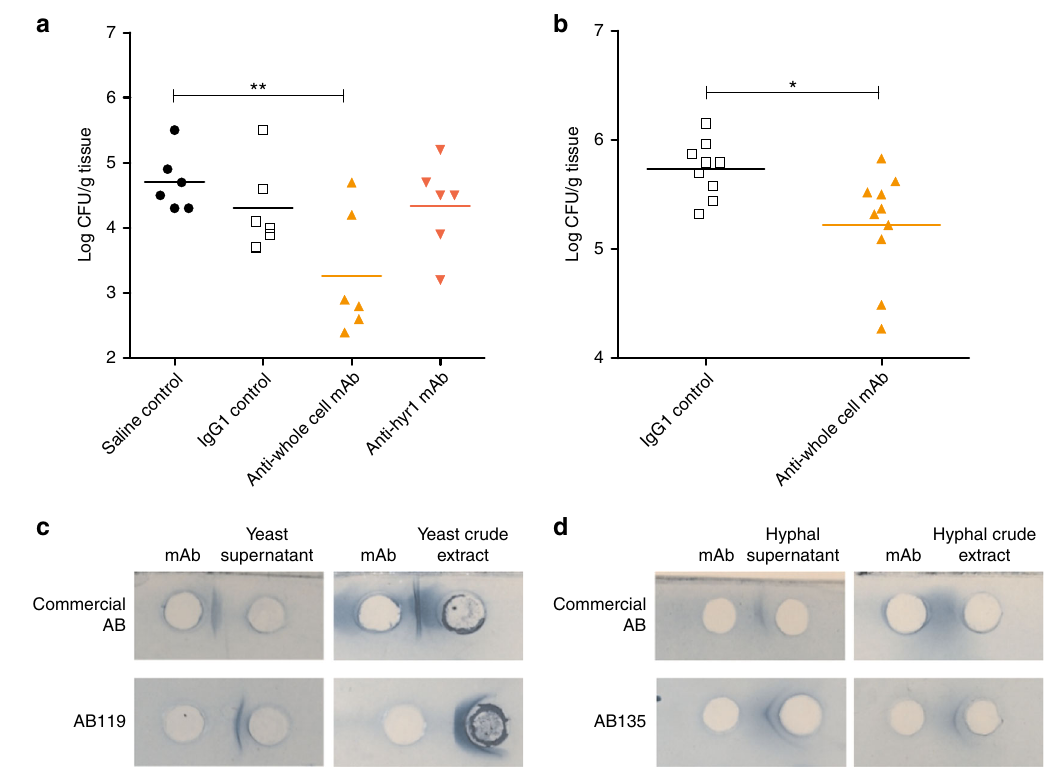
Fig. 10 Assessment of anti- Candida mAbs in murine models of disseminated candidiasis and a routine diagnostic assay. a C. albicans SC5314 was pre- incubated with saline, IgG1 control, anti-whole cell mAb (AB119) or anti-Hyr1 mAb (AB120) and then injected i.v. into the tail vein of female BALB/c mice ( n = 6 per group). Kidney fungal burdens from each group were determined on day 3 post infection. b IgG1 control or anti-whole cell mAb (AB119) was administered i.p. 4 h prior to injection of C. albicans SC5314 i.v. into the lateral tail vein of male CD1 mice ( n = 10 per group). Kidney fungal burdens